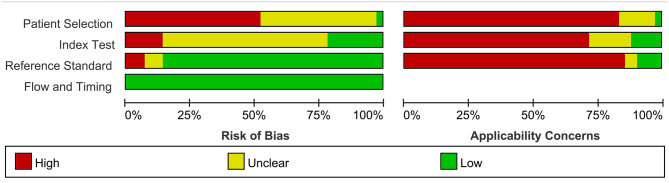
Bar graphs of the methodological quality assessment. Each risk-of-bias and applicability item is presented as percentages across included studies, which indicates the proportion of different levels for each item.